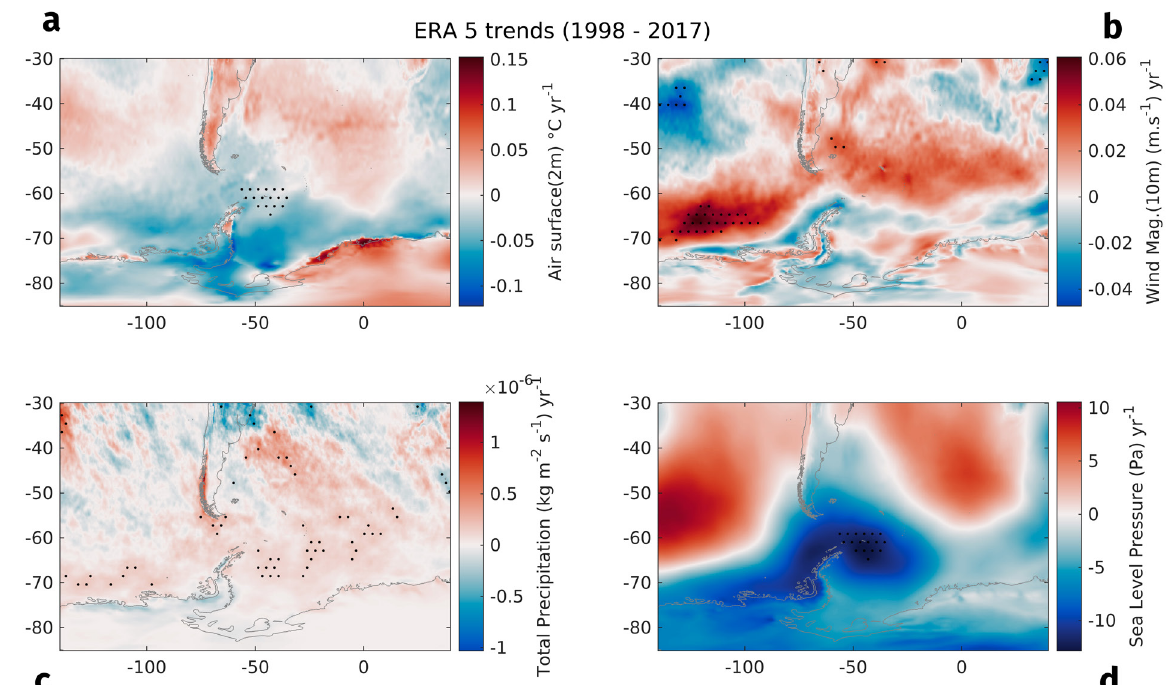
Figure 3. Yearly trends over Antarctic Peninsula through results of ERA5 Reanalysis data between 1998 and 2017), variables: (a) Air temperature at 2m (°C); (b) Wind Magnitude at 10m (m s -1 ); (c) Total Precipitation (kg m 2 s -1 ); (d) Sea level pressure (Pa). Black dots represent the areas with significance of 0.05. Created with Climate Data Toolbox for Matlab (Greene et al.